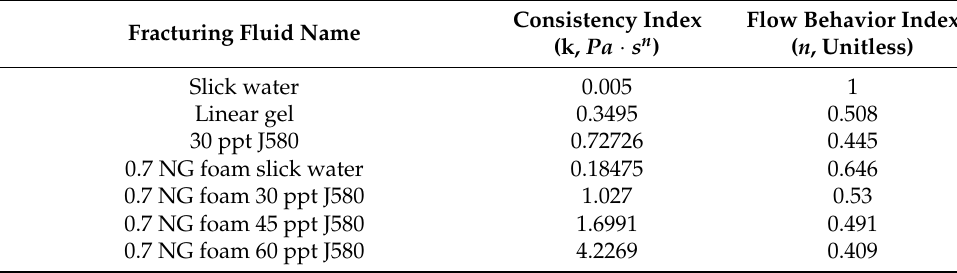
Figure 2. Viscosity versus shear rate for different NG foam and base fluids (from [2]). Table 1. Typical fracturing fluid viscosity